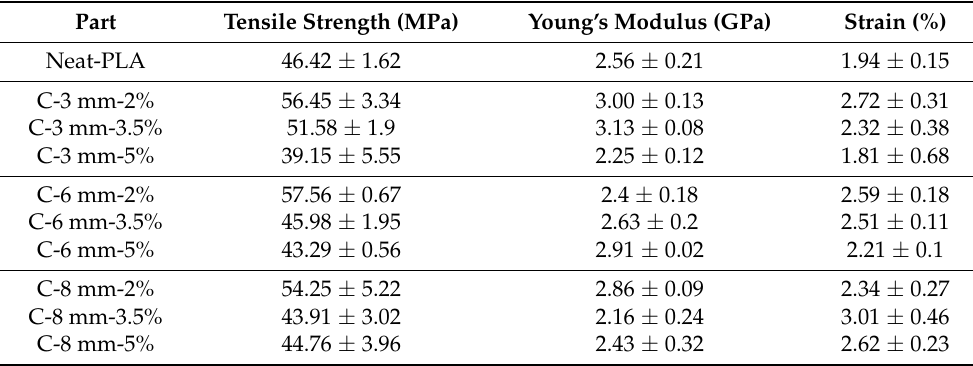
Figure 7. Tensile data of all composites studied: ( a ) tensile strength and ( b ) Young’s modulus. Table 4. Tensile data of all composites